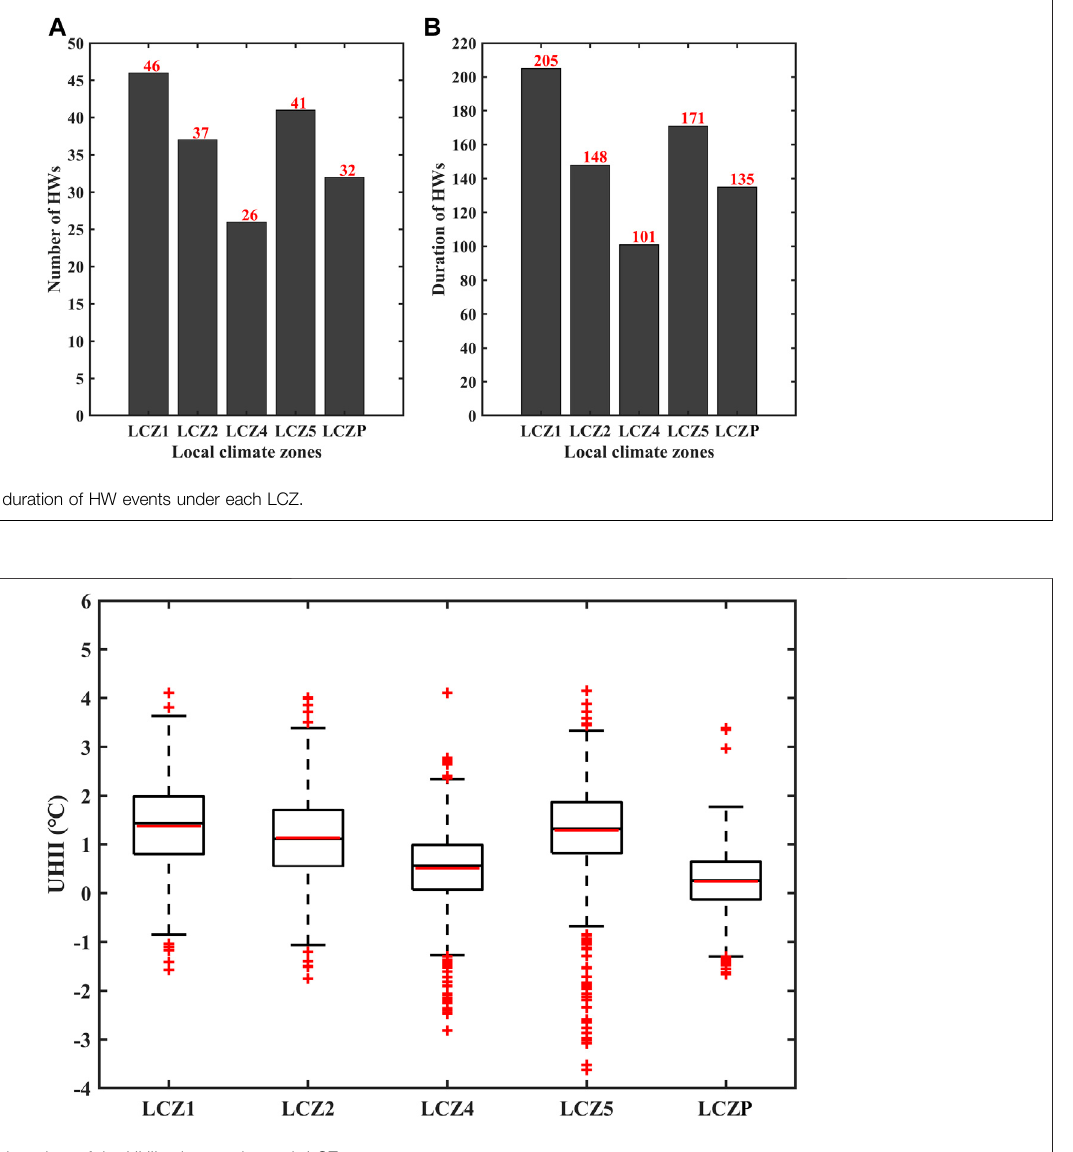
FIGURE 7 | Box-and-whisker plots of the UHII values under each